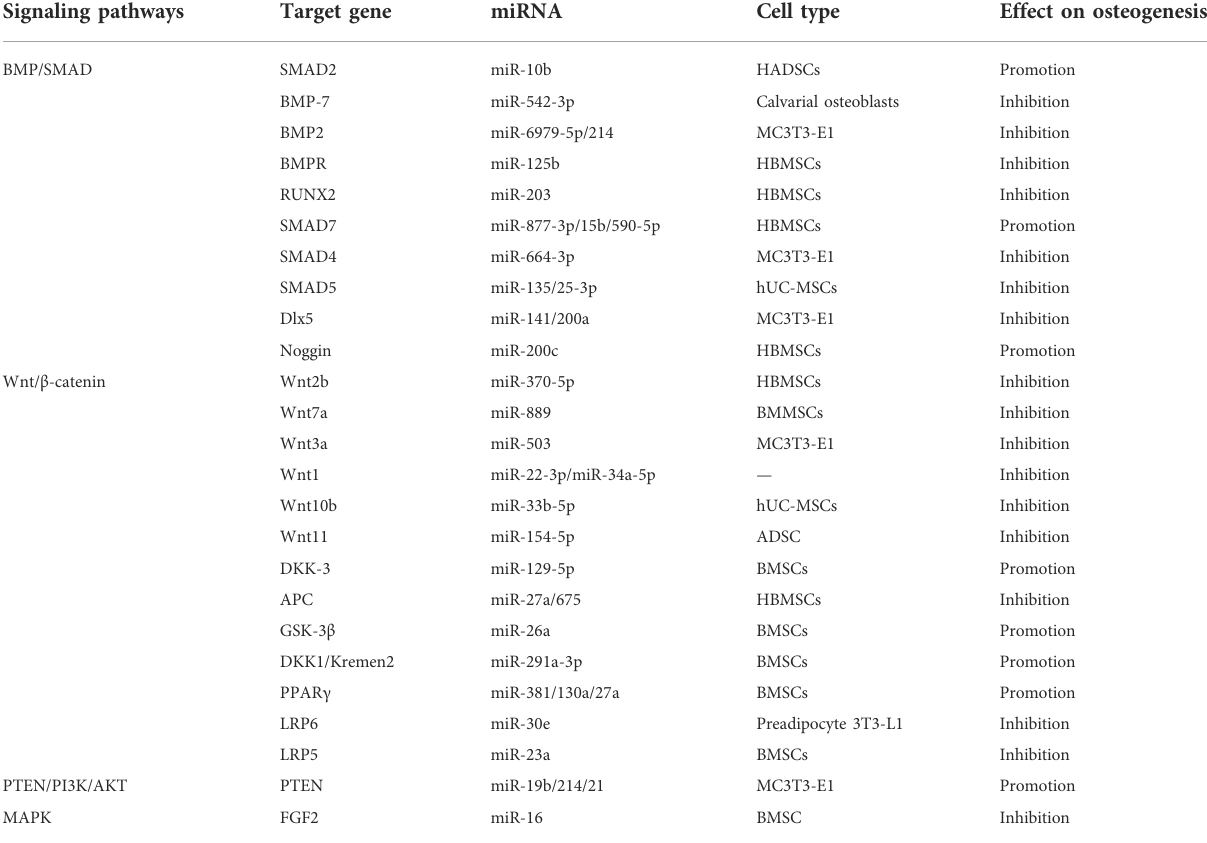
TABLE 1 Summary of target genes of different signaling pathways by miRNAs. Signaling